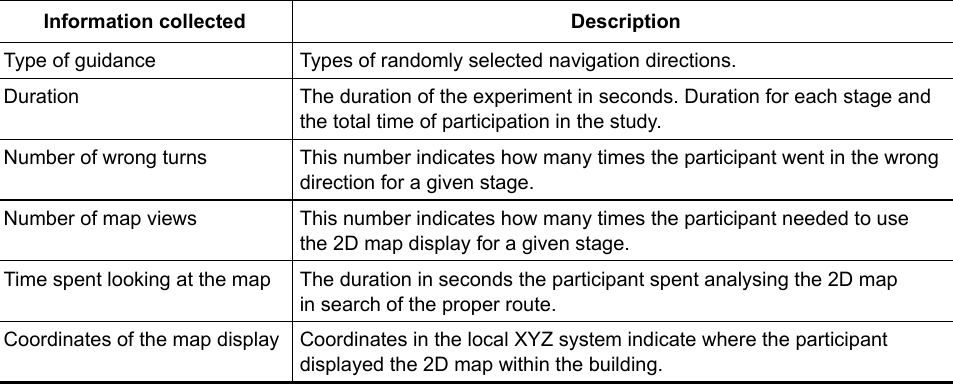
Table 2. Summary of data collected by the research application on completion of each stage Information collected Description